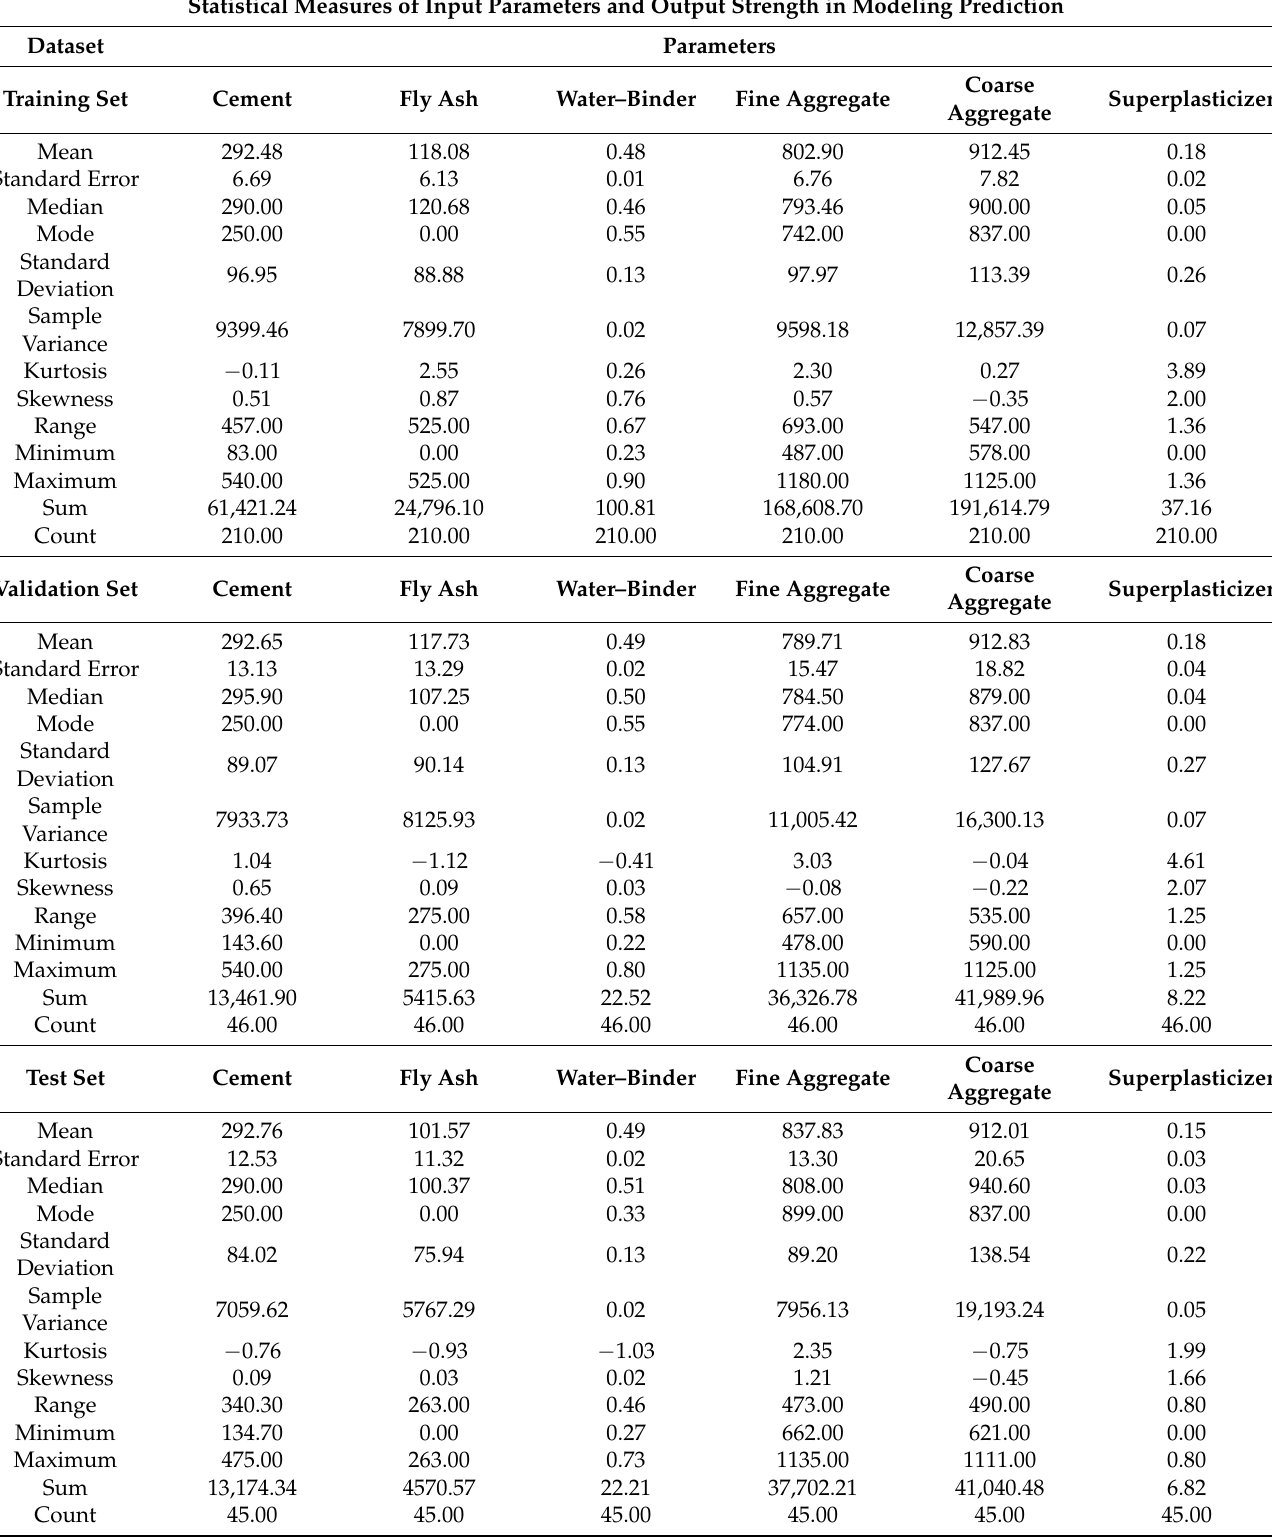
Table 4. The dataset from the latest works in the subject of concrete compressive strength